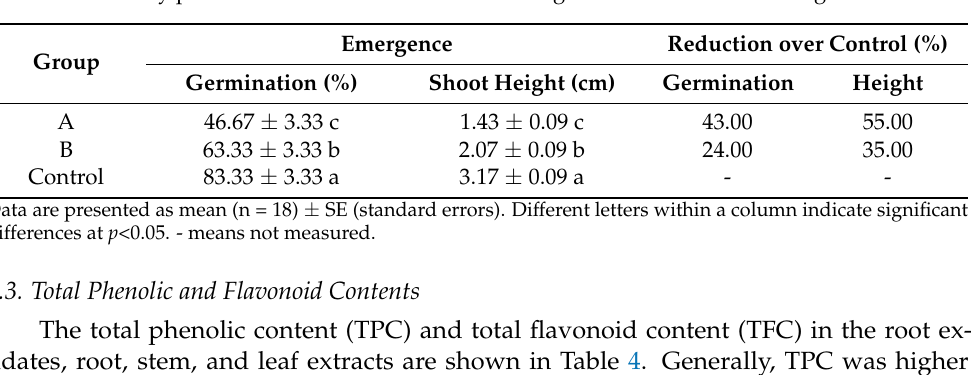
Table 3. Inhibitory potential of root exudates on the seed germination and shoot height of